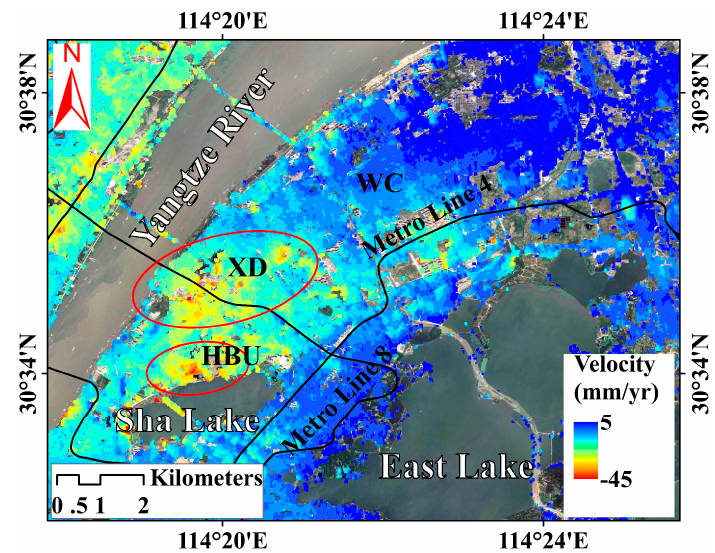
Figure 9. Surface vertical deformation rate map derived by SBAS InSAR superimposed on Google Earth image covering Region S3. Black lines denote the Wuhan Metro Lines, including the metro lines in operation and under construction. Red ellipses represent the two subsidence areas, i.e., XD and HBU subsidence bowls.